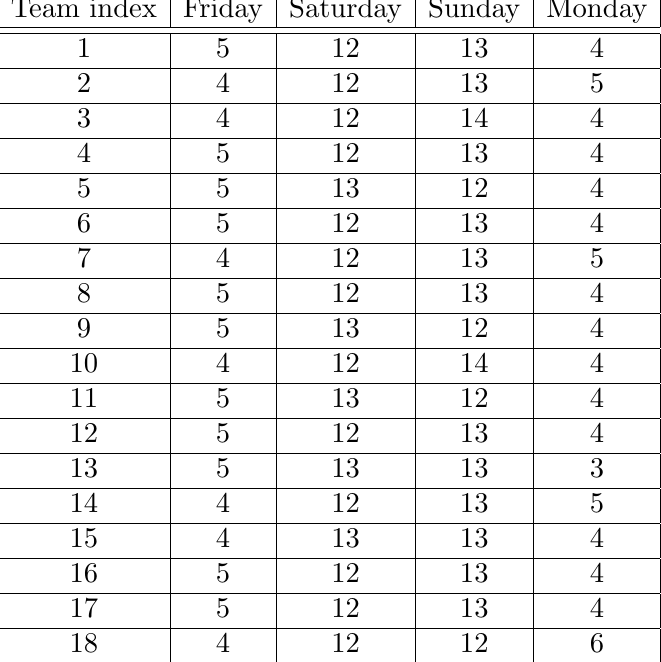
Table 10. The matchday distribution of games obtained by the optimal schedule ( c 2 = 0 .